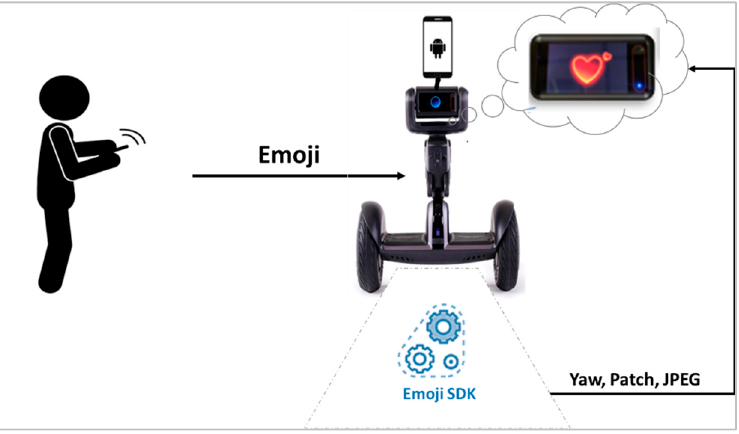
Figure 10. Emoji communication in the communication layer.